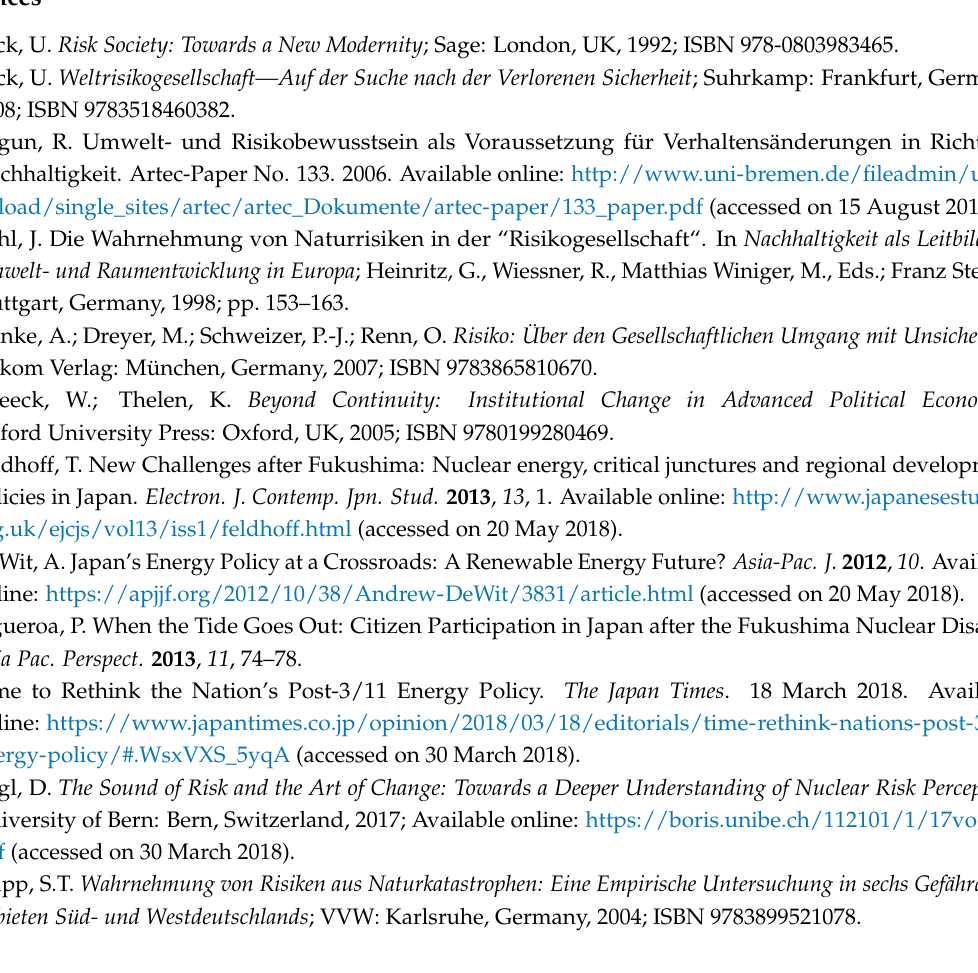
Figueroa, P. When the Tide Goes Out: Citizen Participation in Japan after the Fukushima Nuclear